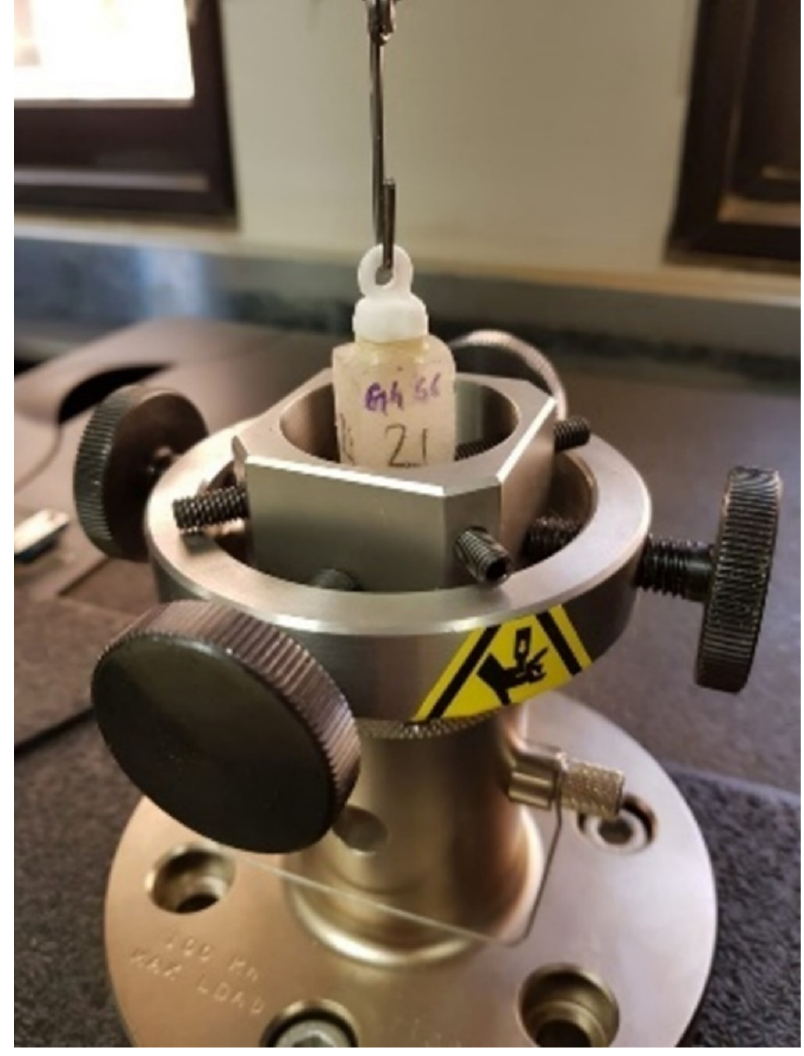
Figure 3. Universal testing machine subjecting copings to dislodgment forces until failure occurred. Table 2. The maximum loads and tensile strengths in Groups